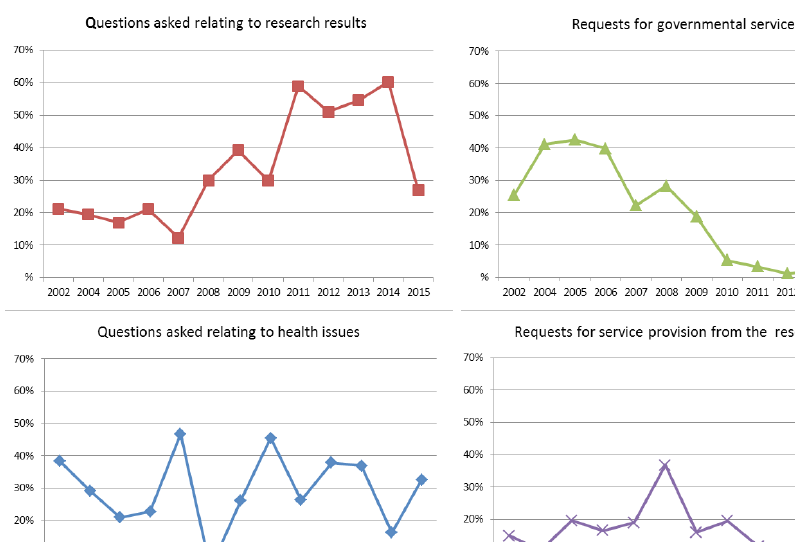
Figure 4: Proportions of